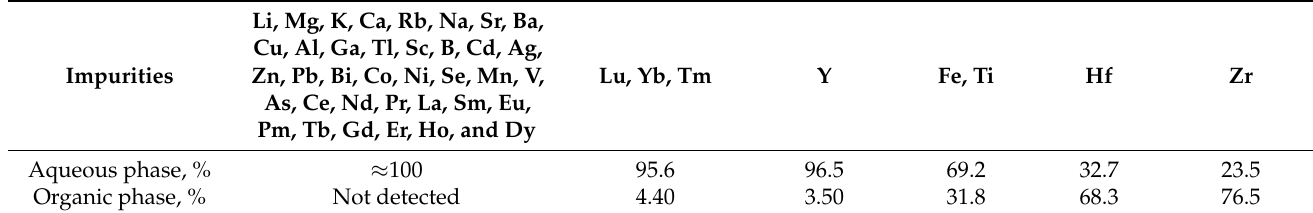
Table 1. ICP-MS for the number of impurities in the two phases after one extraction cycle by 3.0 M HNO 3 , two scrubbing cycles by 6.0 M HNO 3, and two stripping cycles by 1.5 M H 2 SO 4 using 50%